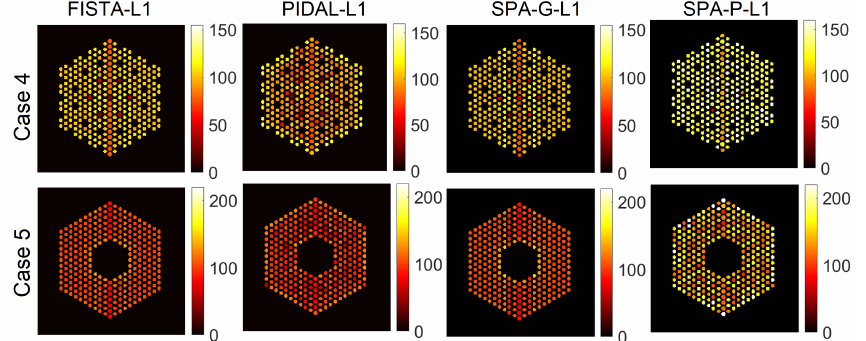
Figure 23. The EMPIRICAL response matrix: activity estimation using pin pixels averaging using existing methods, for Cases “4” and “5”. The regularization parameter β was set to 1 × 10 − 5 in the four